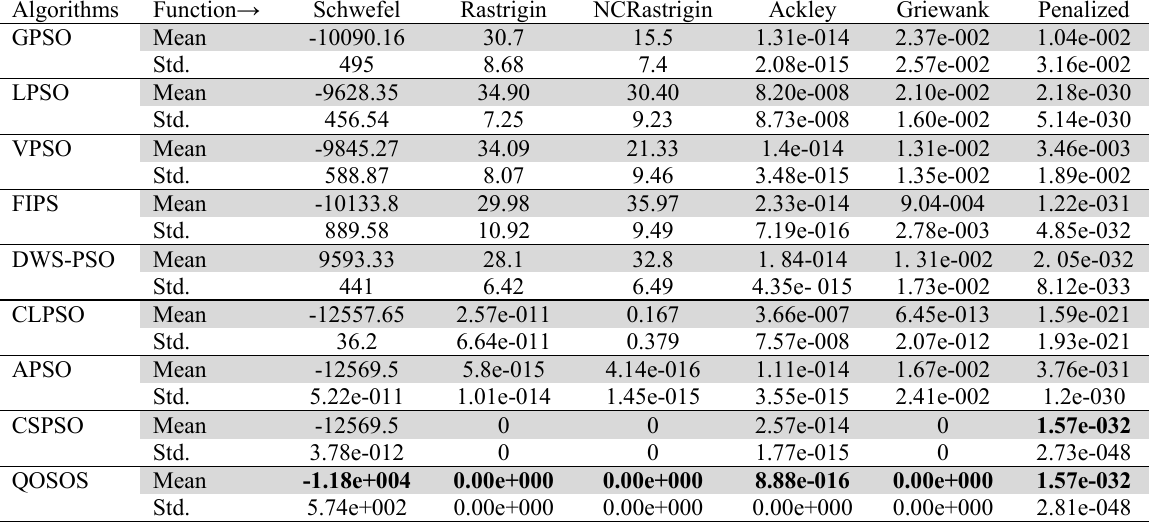
Performance results of GPSO (27), LPSO (28), VPSO (29), FIPS (30), DWS-PSO (31), CLPSO (32), APSO (33), CSPSO (21) and QOSOS at dimensions (D) 30 after reaching D*5000 FEs of eight well known test functions over 20 runs with 40 eco-size. ‘‘Mean ’’ and ‘‘std.’’ show the average and standard deviation of the test functions respectively. Boldface represents the best result among the compared algorithms Algorithms